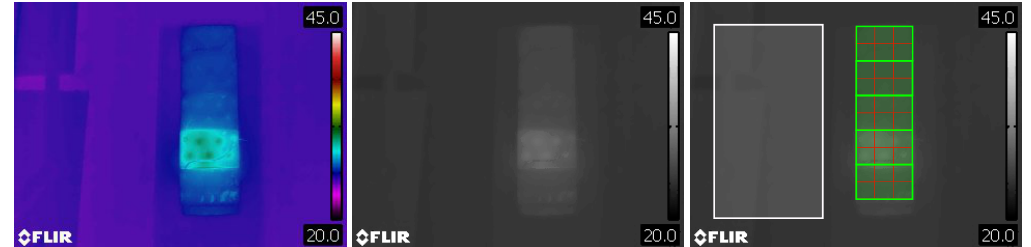
Figure 4. The input thermal image in RGB space ( left ); the image transformed to the temperature space ( center ); and the the image with highlighted areas of batteries (green), battery segments (red), and battery surroundings (white) ( right